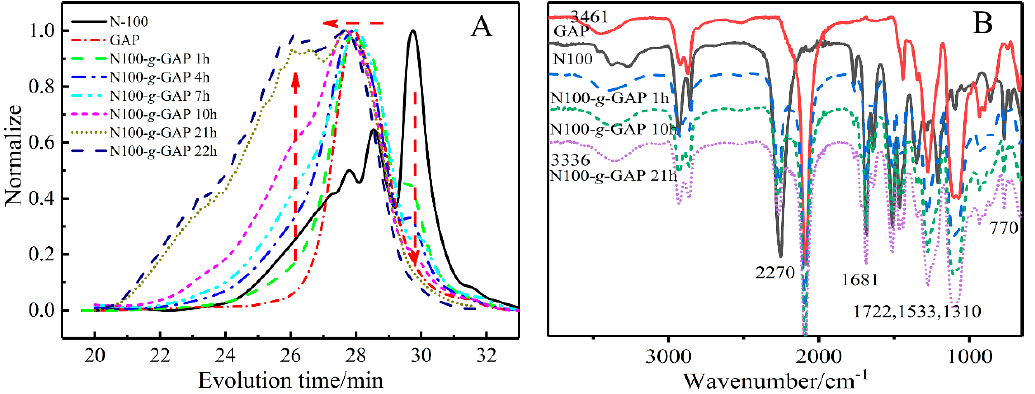
Figure 1. ( A ) Gel permeation chromatography (GPC) variation of molecular weight of N100- g -GAP with reaction time, ( B ) FT-IR analysis of N100- g -GAP and raw materials.